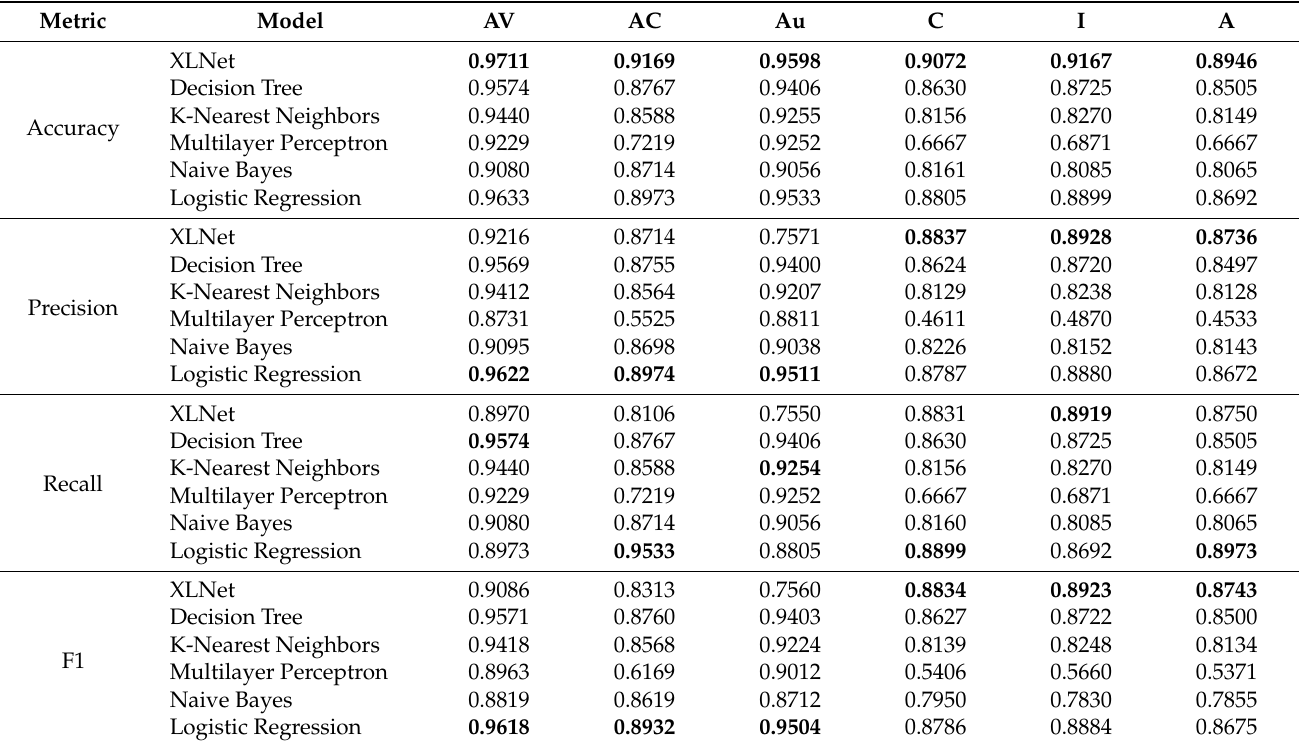
Table 7. The impact of traditional machine learning models and fine-tuned XLNet on the CVSS v2